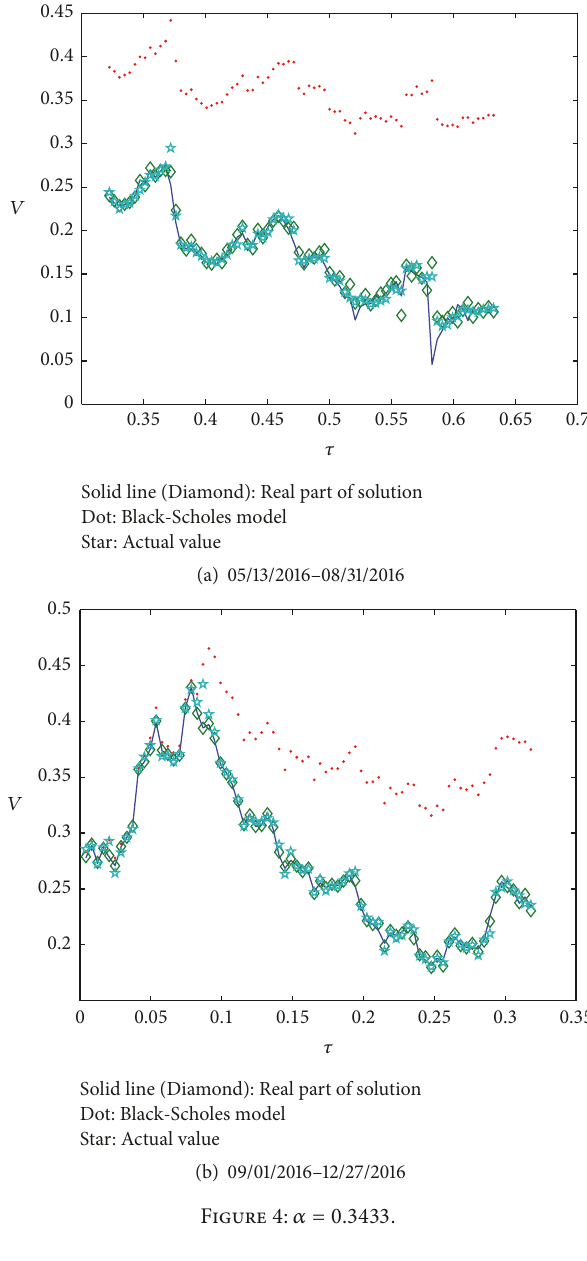
Figure 4: 𝛼 = 0.3433